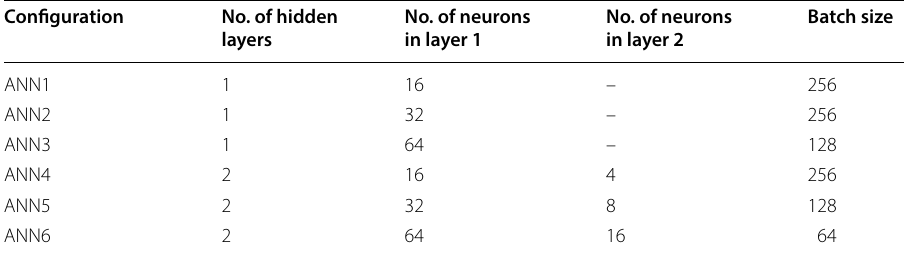
Table 1 Employed ANN configurations Configuration No. of hidden